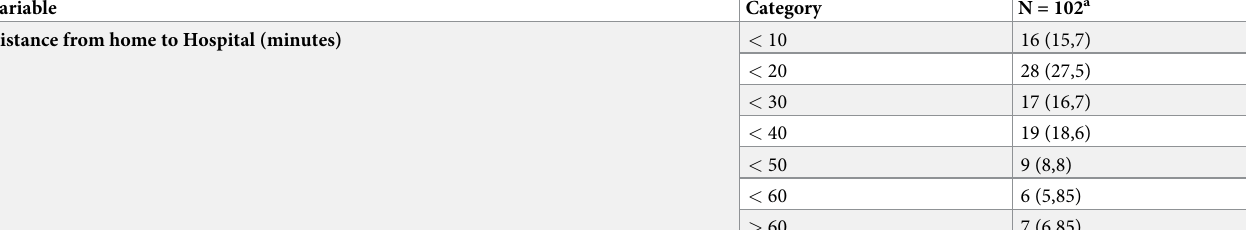
Table 6. The characteristics of the use of pediatric dental